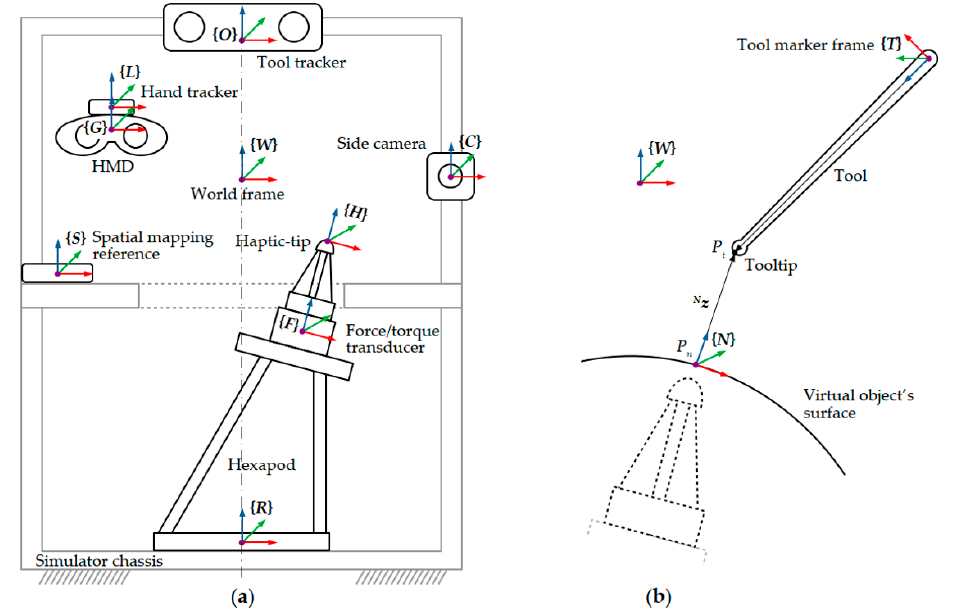
Figure 4. Coordinate frames: overall system ( a ), tool tracking ( b ).